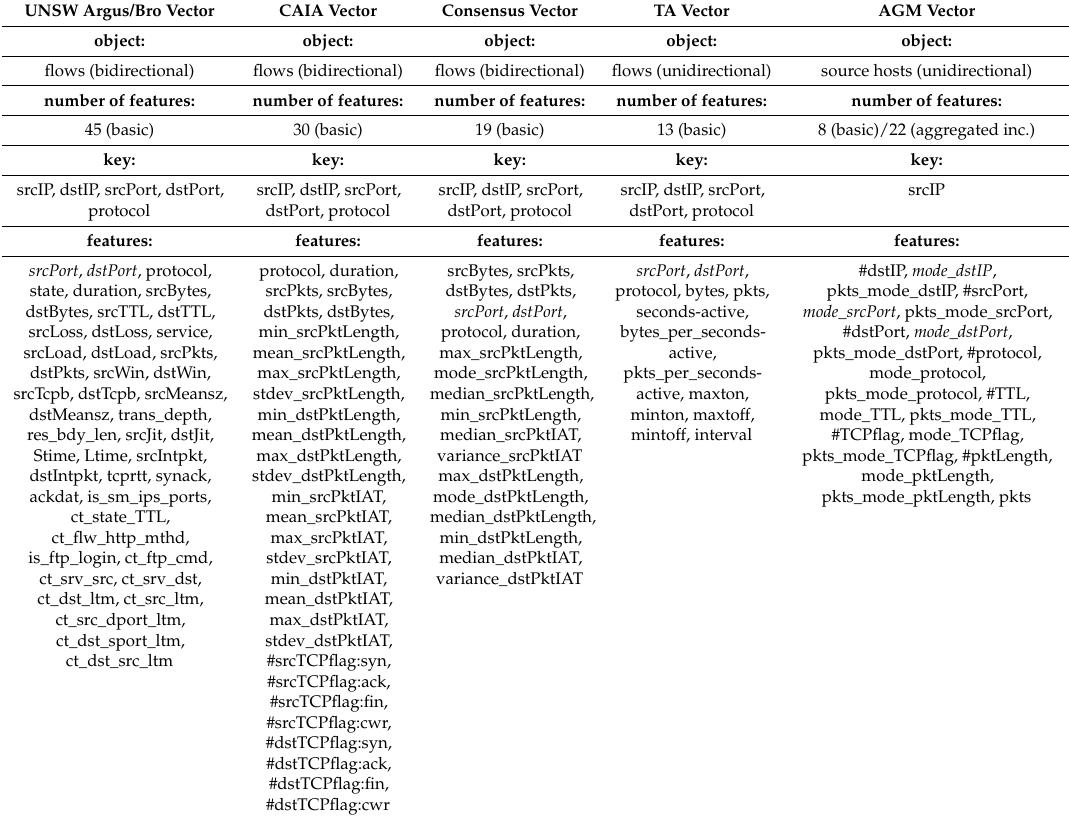
Table 1. Feature sets under